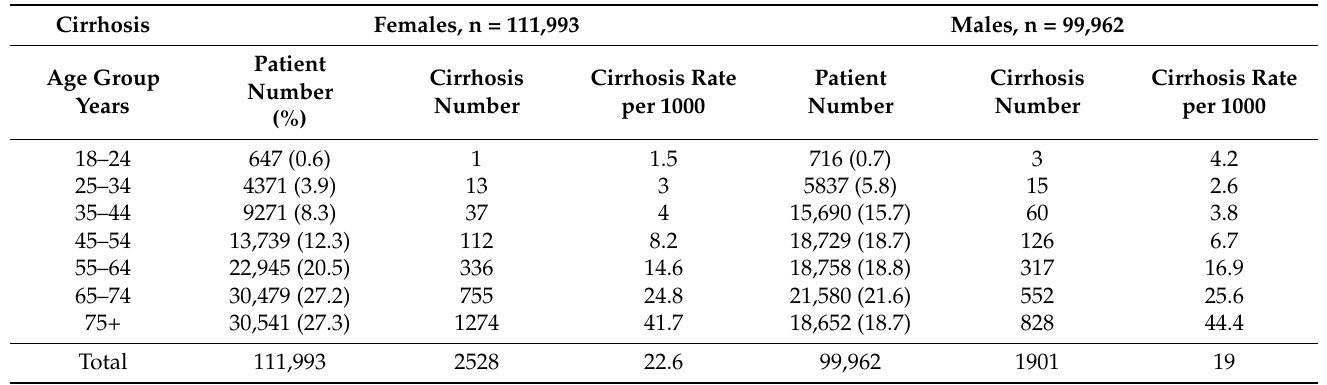
Table 4. Cirrhosis rate according to age group among females and males with NAFLD.